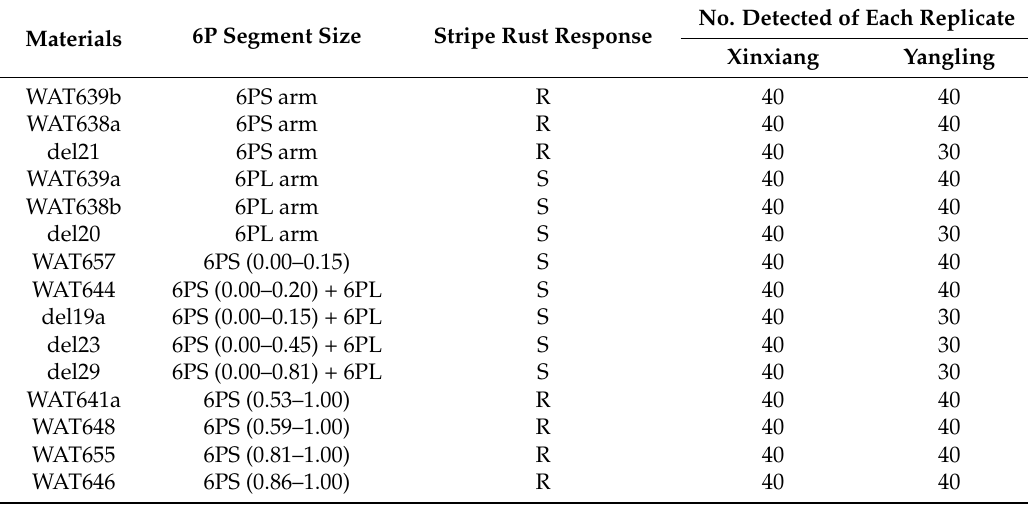
6P segment size: The comparison of the length of 6P segments and intact 6P arm. The position of the centromere was considered as 0, while the terminal end of the 6PS/6PL arm was considered as 1. The letters R and S in “Stripe rust response” column indicated plants were resistant and susceptible,